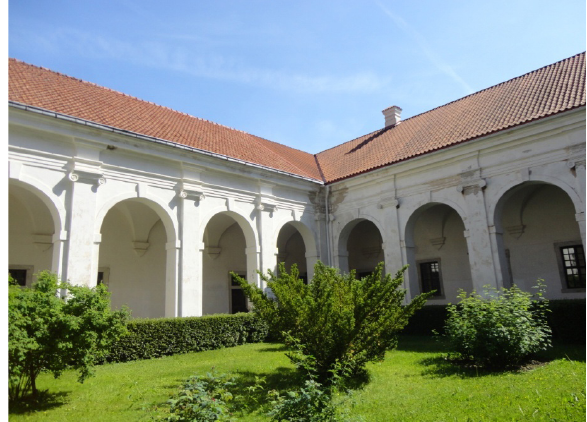
Figure 7. Cloister garden in Pažaislis, Lithuania (photo by the author of the article)